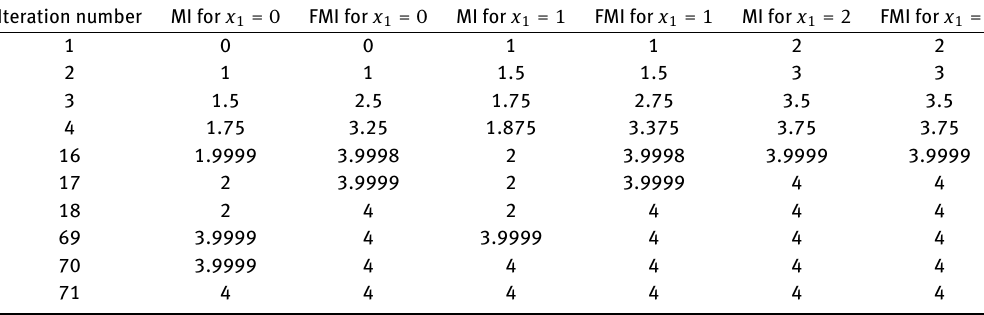
Table 1: Convergence table of Mann iteration and Fibonacci-Mann iteration for t n = .5 . Iteration